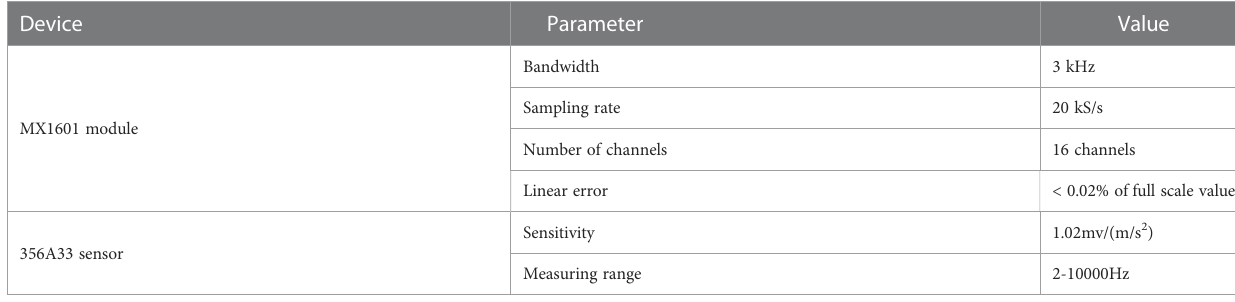
TABLE 1 Parameter values of the MX1601 module and acceleration